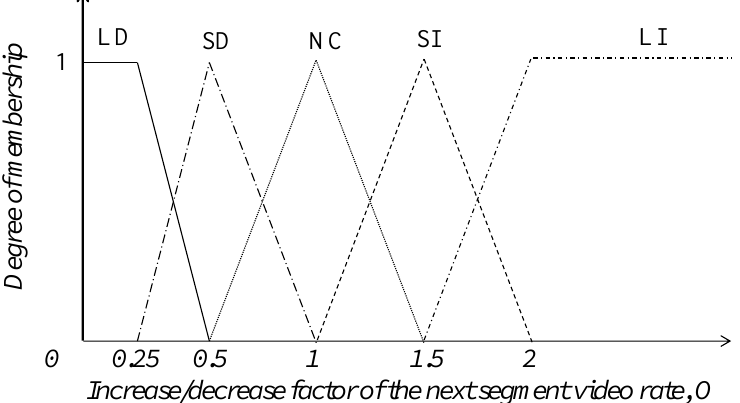
Figure 5. Output of the fuzzy logic controller.